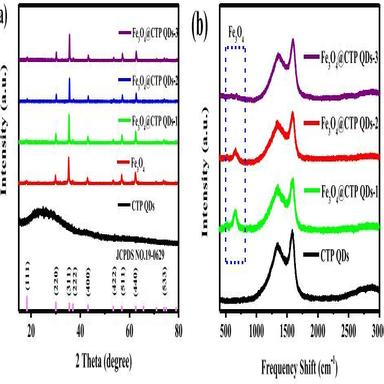
(a) XRD patterns and (b) Raman spectra of CTP QDs, pure Fe3O4 and Fe3O4@CTP QDs composites with different amount of CTP QDs.